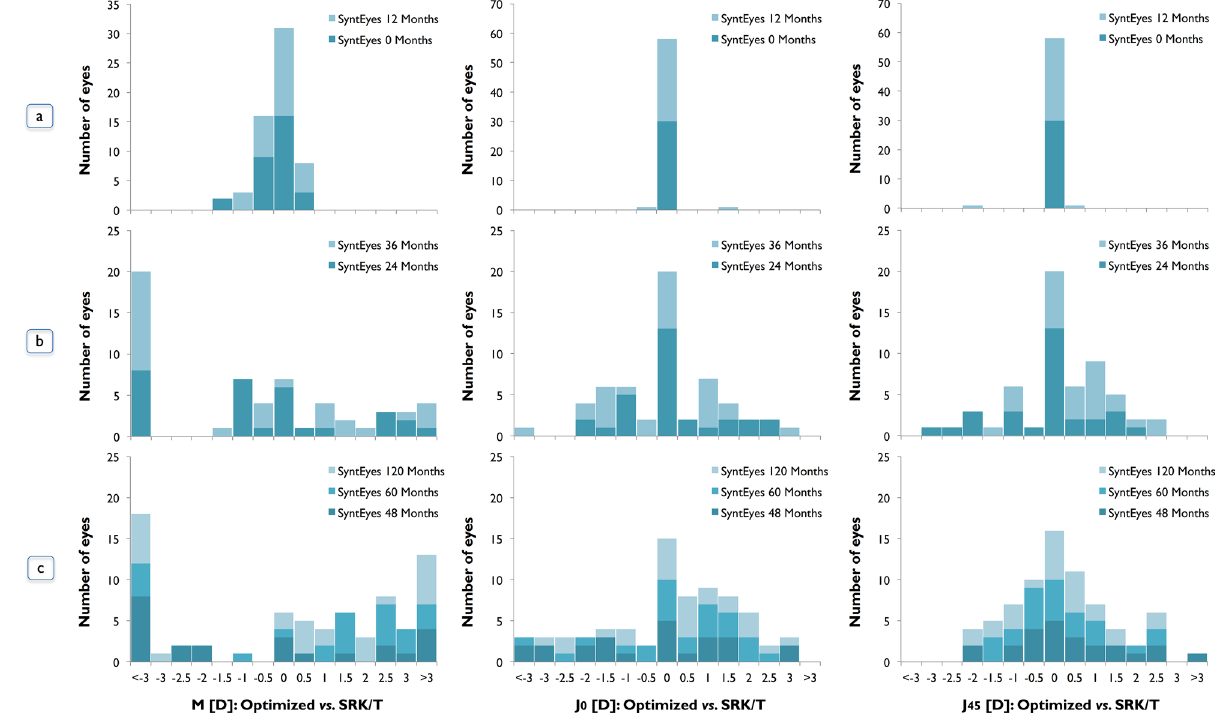
Figure 7. Difference in residual refractive error between RTO and SRK/T expressed as power vectors M, J 0 and J 45 . ( a ) Regular astigmatism: Normal—SyntEyes 0 and 12 months; ( b ) irregular astigmatism and HOAs: SyntEyes with simulated progression of 24 and 36 months (mid-stage KC); ( c ) irregular astigmatism and higher amount of HOAs: SyntEyes with simulated progression of 48, 60 and 120 months (late-stage